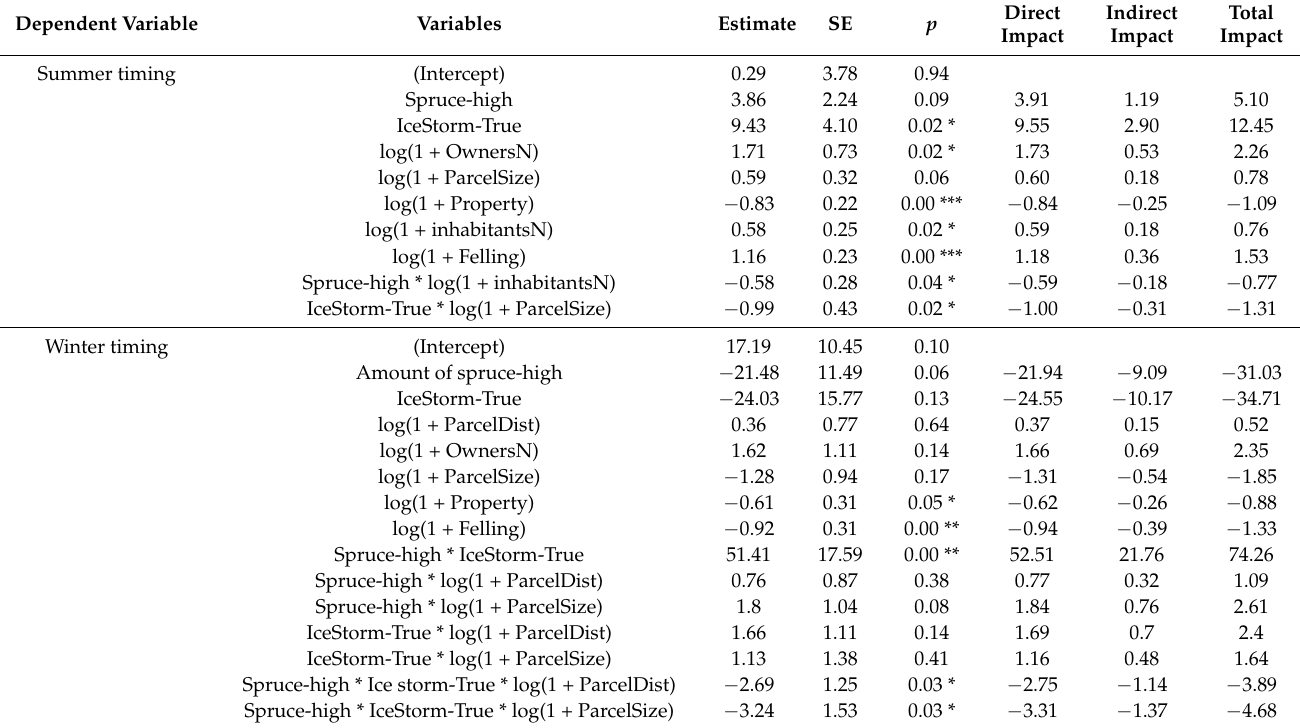
Table 3. Model statistics of the spatial lag model of the timing of sanitary felling in summer and winter. Variables, estimates, standard error, z value, and p values are shown. Adapted direct and indirect impact values of the models are included. * p < 0.05, ** p < 0.01, *** p < 0.001. Direct impact values show the direct feedback of neighboring parcels in the dataset to the particular parcel. The indirect impact shows the changes in all observations also called spatial spillover. The total impact is the sum of the indirect and direct impact